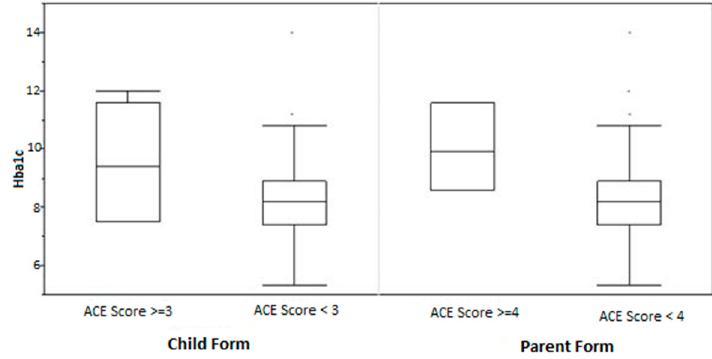
Figure 3. Relationship between ACE scores and HbA1c.